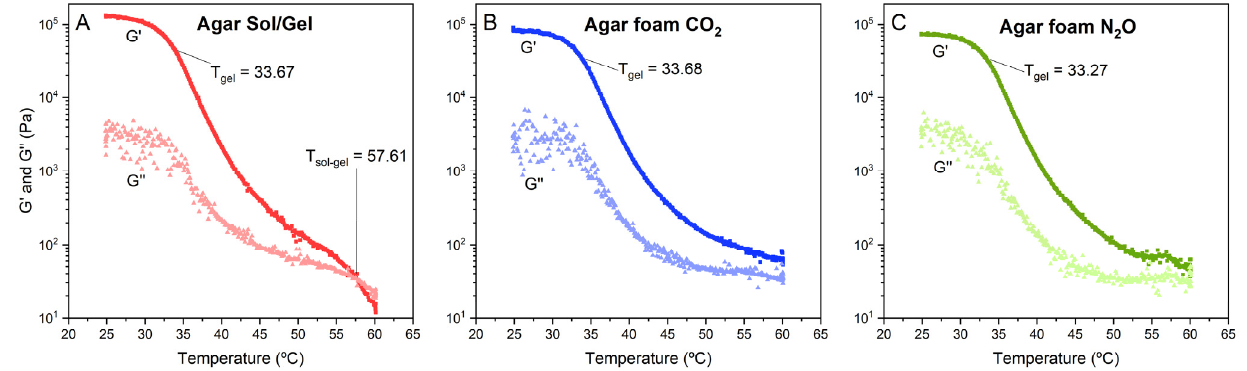
Figure 5. Temperature ramp analysis for the three systems ( A ) agar sol/gel, ( B ) CO 2 foam, and ( C ) N 2 O foam. The sol-gel transition temperature (T sol-gel ) is marked for graph ( A ) and depicted as the crossover point between G ′ and G ″ . The values of the gelification temperature (start of the plateau region) are marked as T gel for all graphs.